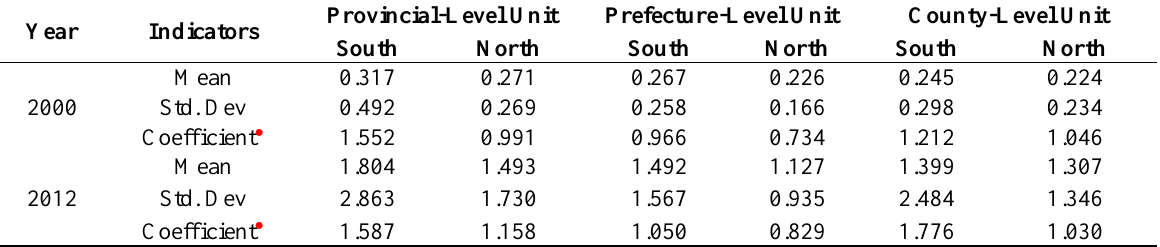
Table 4. Difference in spatial field of administrative units at various levels in “the north” and “the south” of